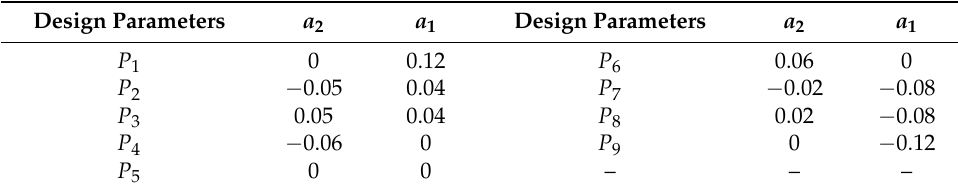
Table 2. Nine groups of design